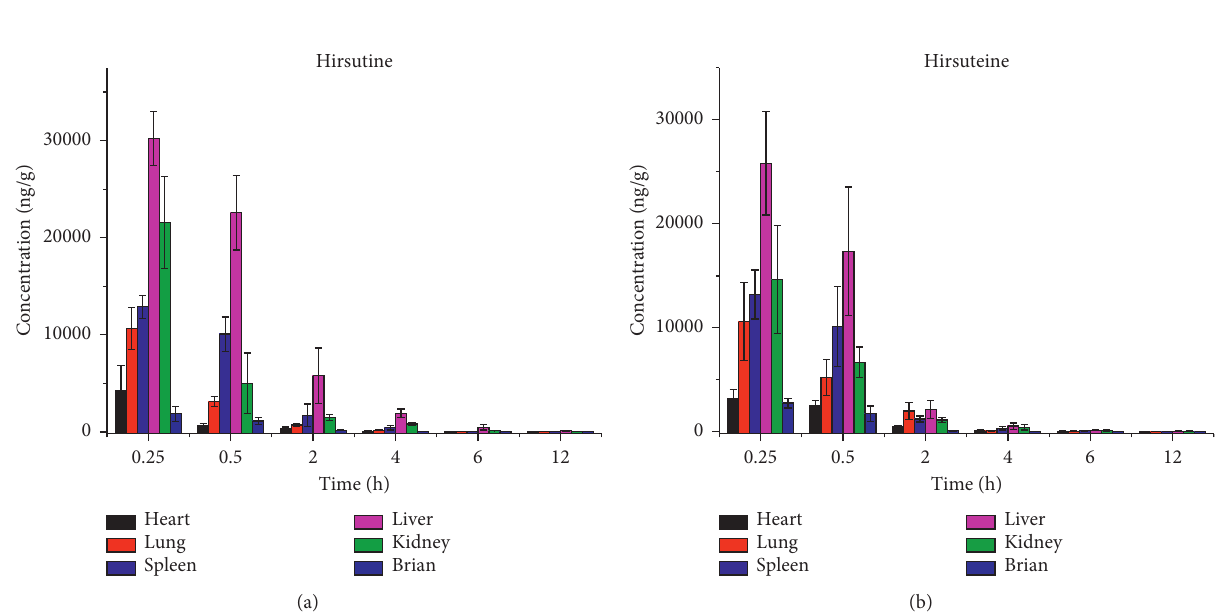
Figure 2: Tissue distribution in mice after intraperitoneal administration of 10 mg/kg of hirsutine and